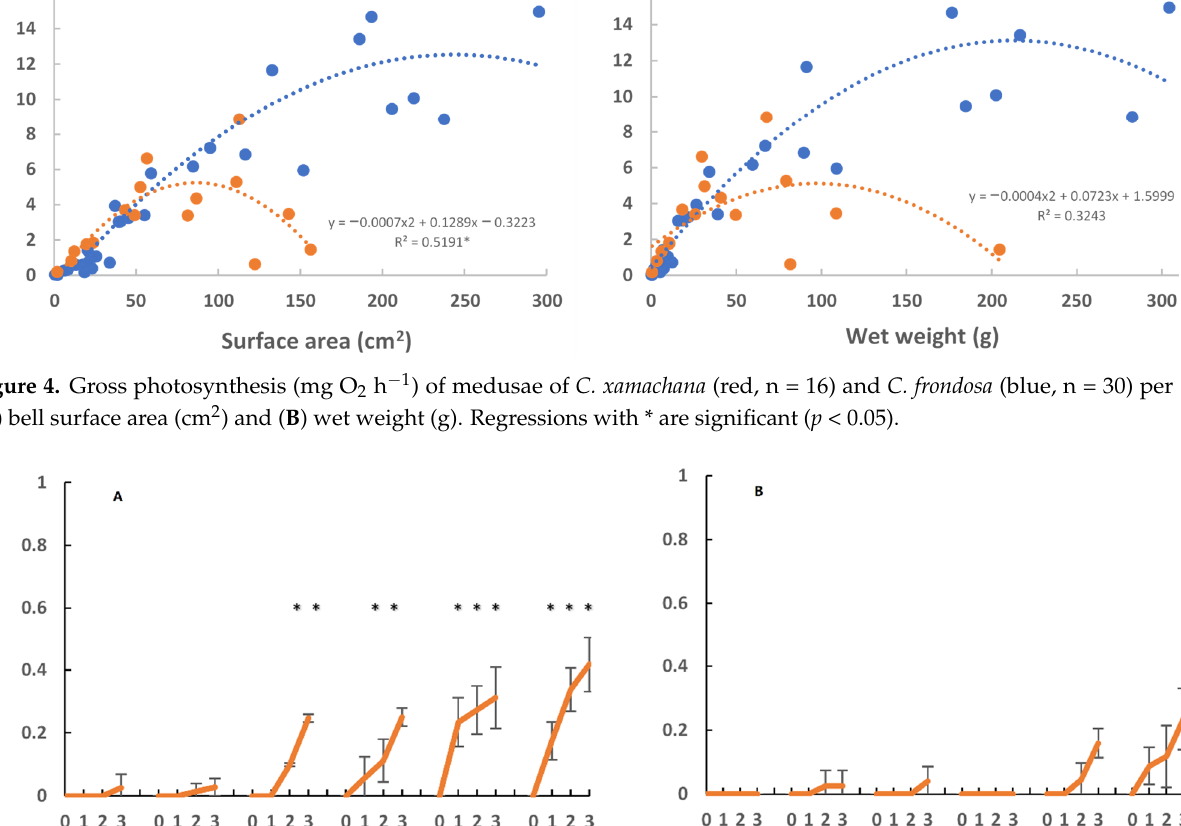
Figure 6. Settlement and metamorphosis of C. xamachana ( A ) and C. frondosa ( B ) on substrates from a shallow habitat (1–2 m) for 4 days (orange = Day 0, yellow = Day 1, green = Day 2, maroon = Day 3, brown = Day 4). Mean ± s.d. (n = 4).